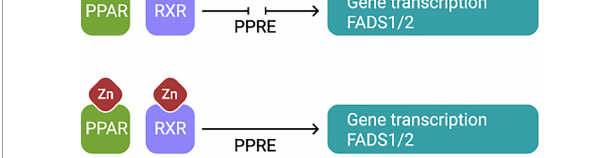
FIGURE3 PPARs form a heterodimer with RXR and simultaneously they bind to the PPAR response element for transcriptional activation of FADS1 and FADS2 genes. Both, PPAR α and RXR have in the DNA binding domain characteristics Zn fingers domains essential for appropriate function of the protein. Thus, Zn plays an essential role in the function of these transcription factors. PPARS, The peroxisome